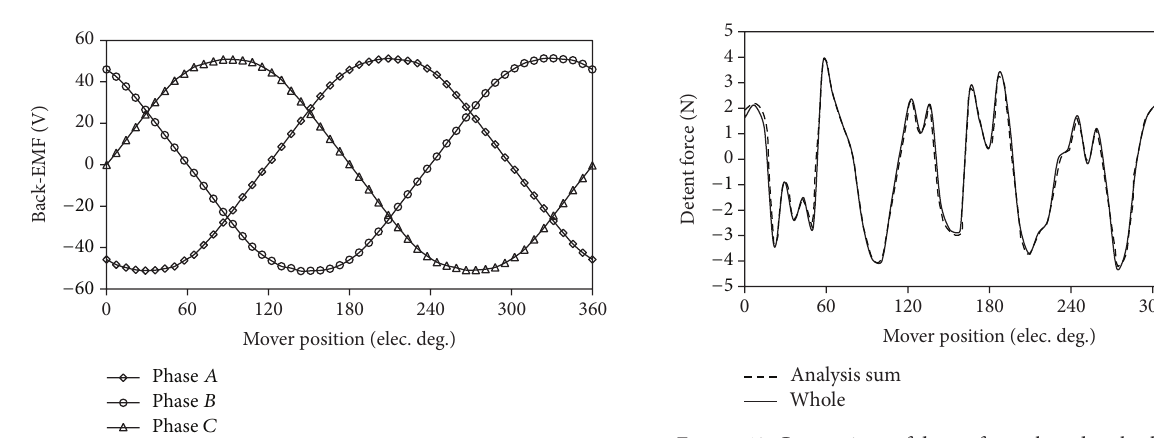
Figure 10: Three-phase back-EMF waveforms.